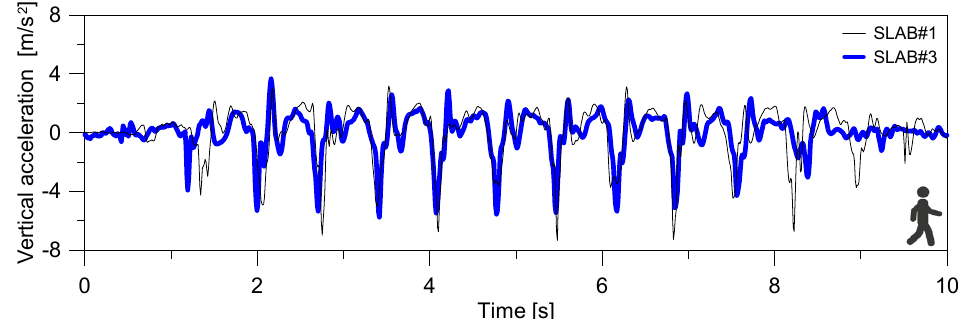
Figure 6. Example of experimentally derived body CoM accelerations (vertical component) for the volunteer walking on rigid SLAB#1 or flexible, low frequency, SLAB#3 systems.